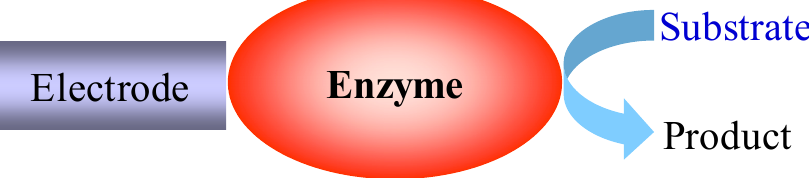
Figure 1. Schematic view of direct electron transfer (DET)-type bioelectrocatalysis.